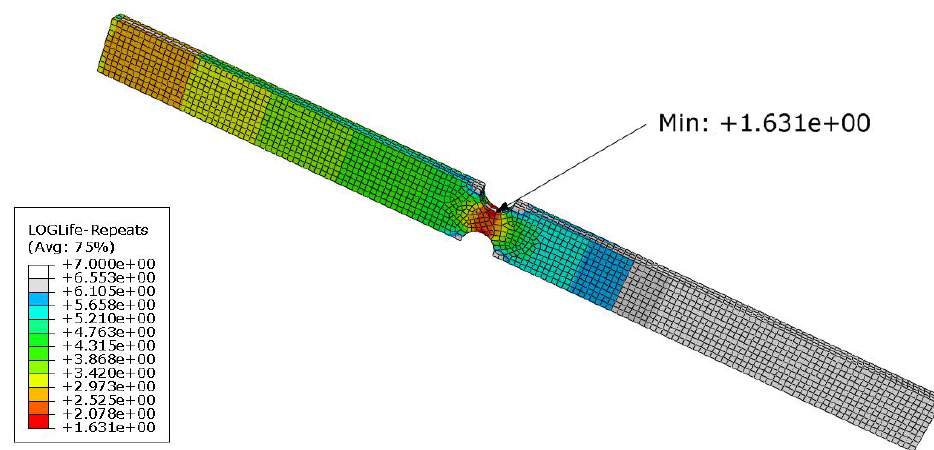
Figure 15. The results of fatigue life analysis for the reference PSD D.